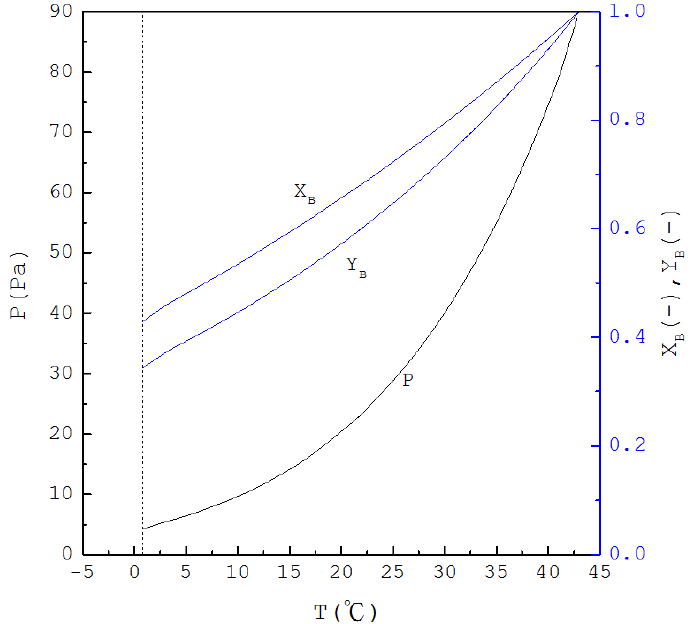
Figure 2. The calculated results of 𝑃(𝑇) , 𝑋 𝐵 (𝑇) and 𝑌 𝐵 (𝑇) for the formation of p -chlorophenol solid product from the liquid mixture via the three-phase transformations.